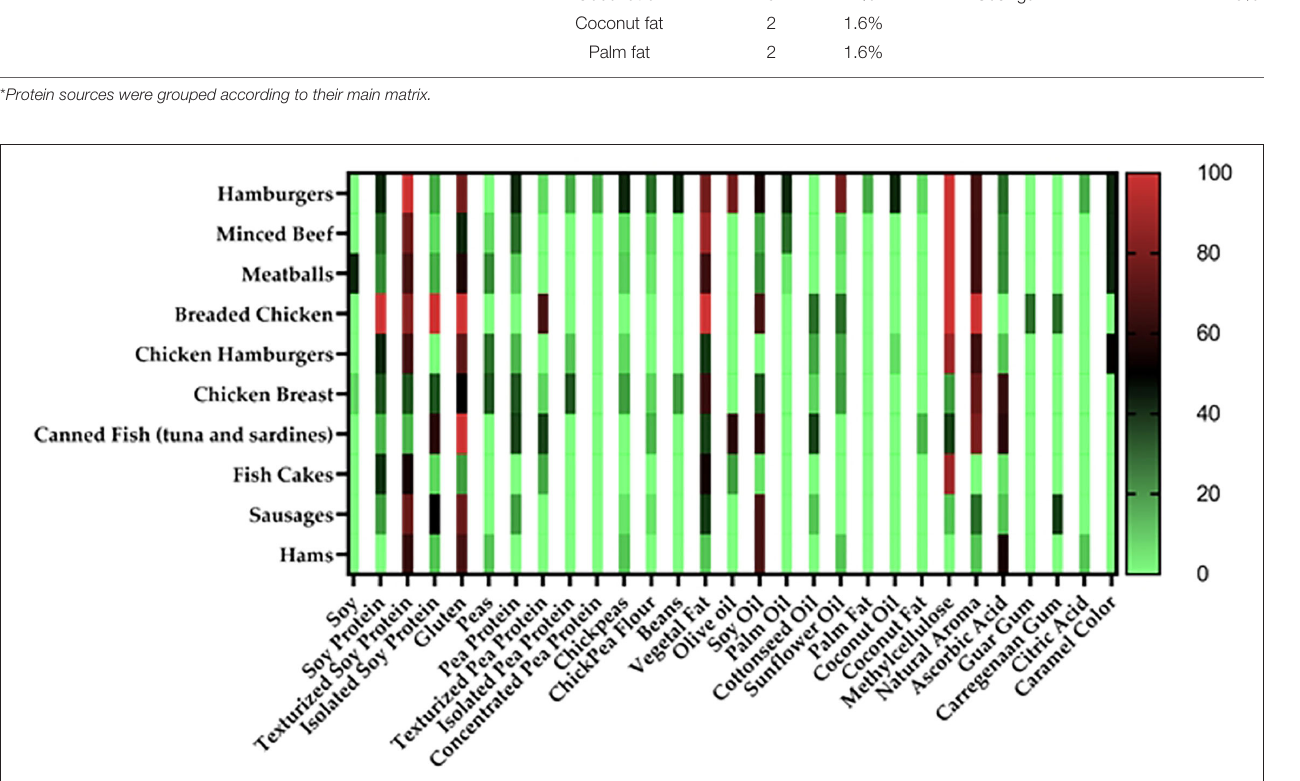
Protein containing chickpea ingredients Protein containing beans ingredients